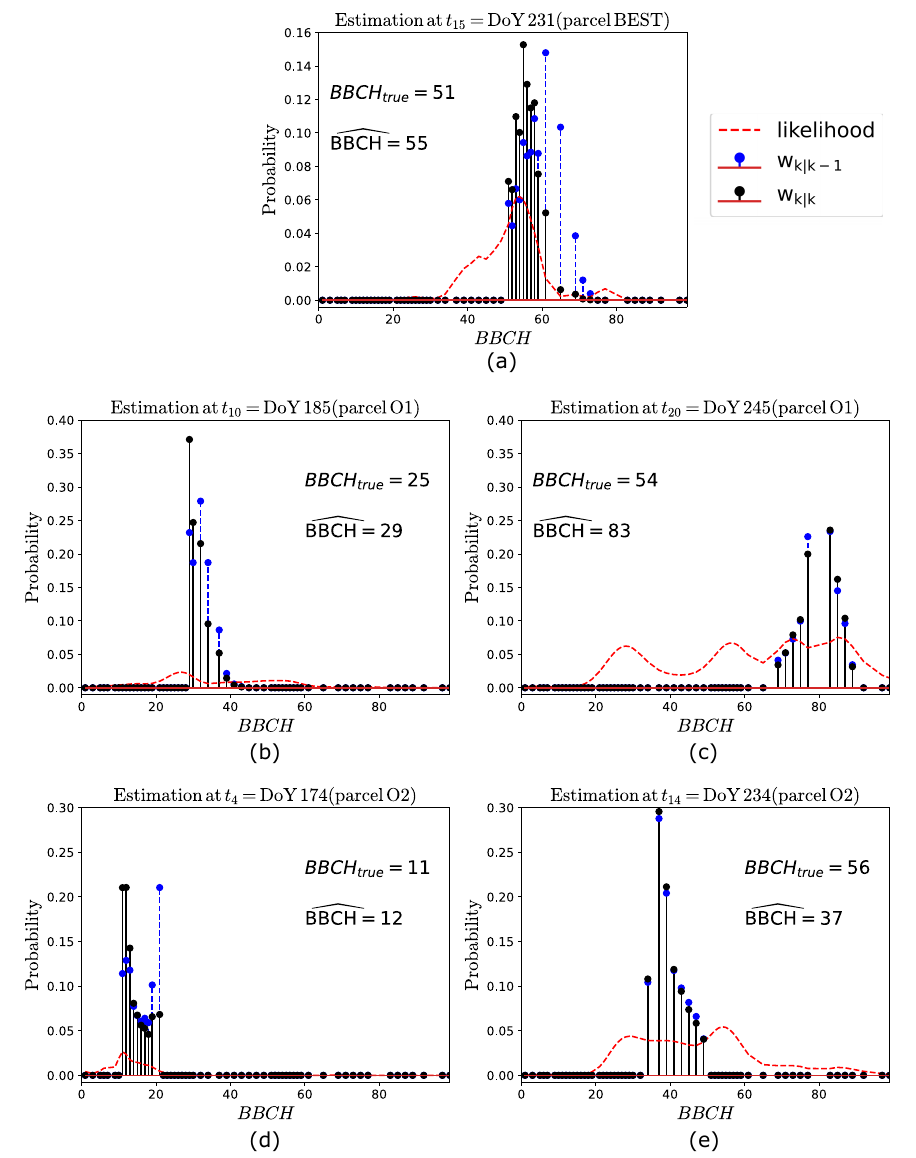
Figure 7. Examples of phenology estimation at different acquisition dates for ( a ) parcel BEST, ( b , c ) parcel O1, and ( d , e ) parcel O2. The true and the estimated BBCH are annotated in the